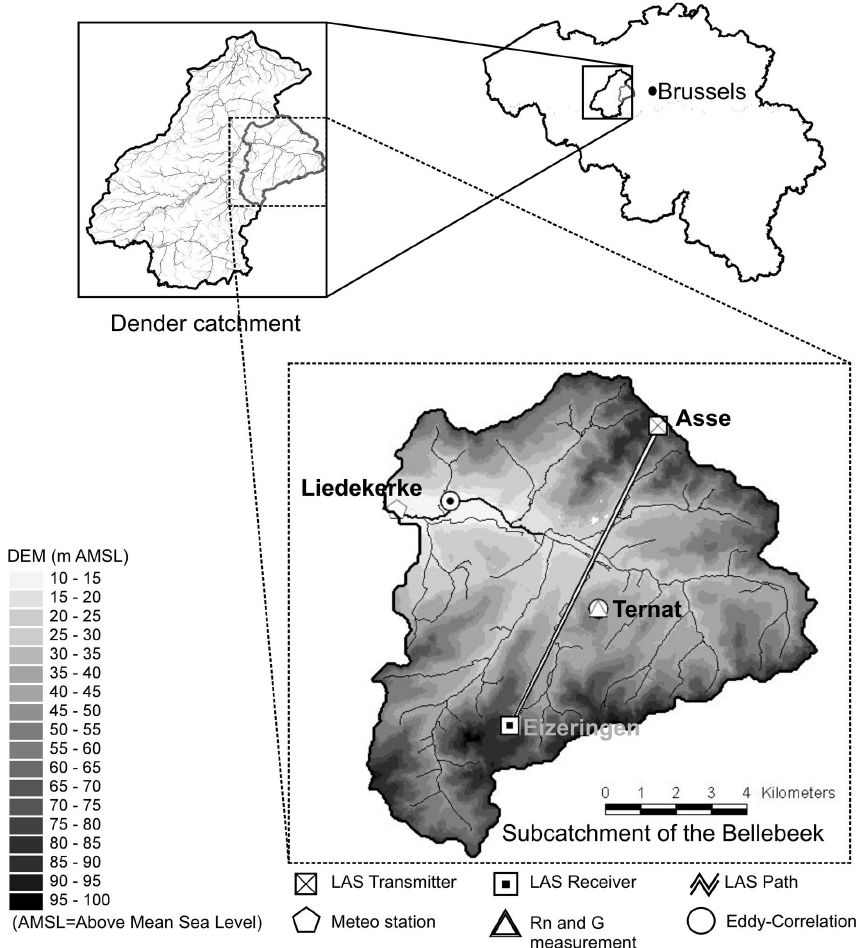
Fig. 1. The location of the study site in Belgium, a DEM of the study area and the location of the meteorologic stations and the LAS in the study